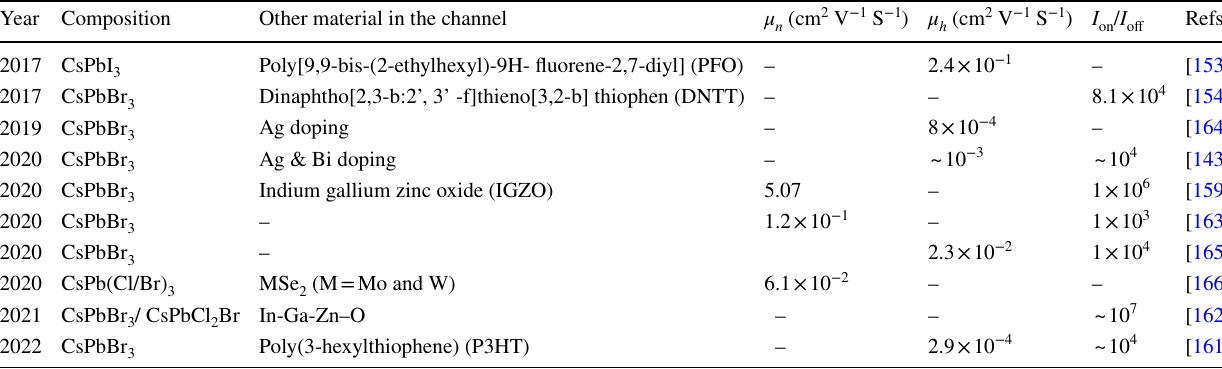
Table 2 Comparison of performance parameters for perovskite QD-based transistors Year